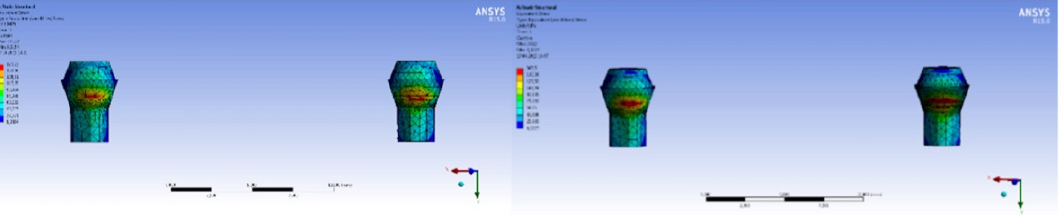
Figure 6. The Von Mises stress distribution on Model 2 and Model 3 multi-unit abutment after horizontal loading.